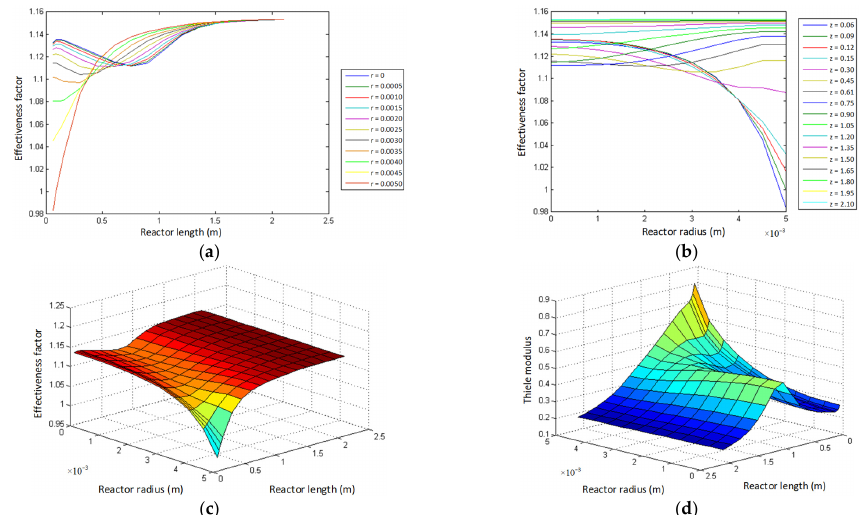
Figure 3. Representation of the profiles inside the particle in the cyclohexanol dehydrogenation process: ( a ) profile of the effectiveness factor as a function of the length for each placement point along the radius of the reactor, ( b ) profile of the effectiveness factor as a function of to the radius of the reactor for each length, ( c ) profile of the effectiveness factor as a function of the length and radius of the reactor (obtained from Table A4), and ( d ) profile of the Thiele modulus as a function of the radius and length (obtained from Table A3). The conversion profiles (Figure 1a,b) and temperature in the bed (Figure 2a,b) are external conditions of the catalyst particles and are a function of radius and length, they